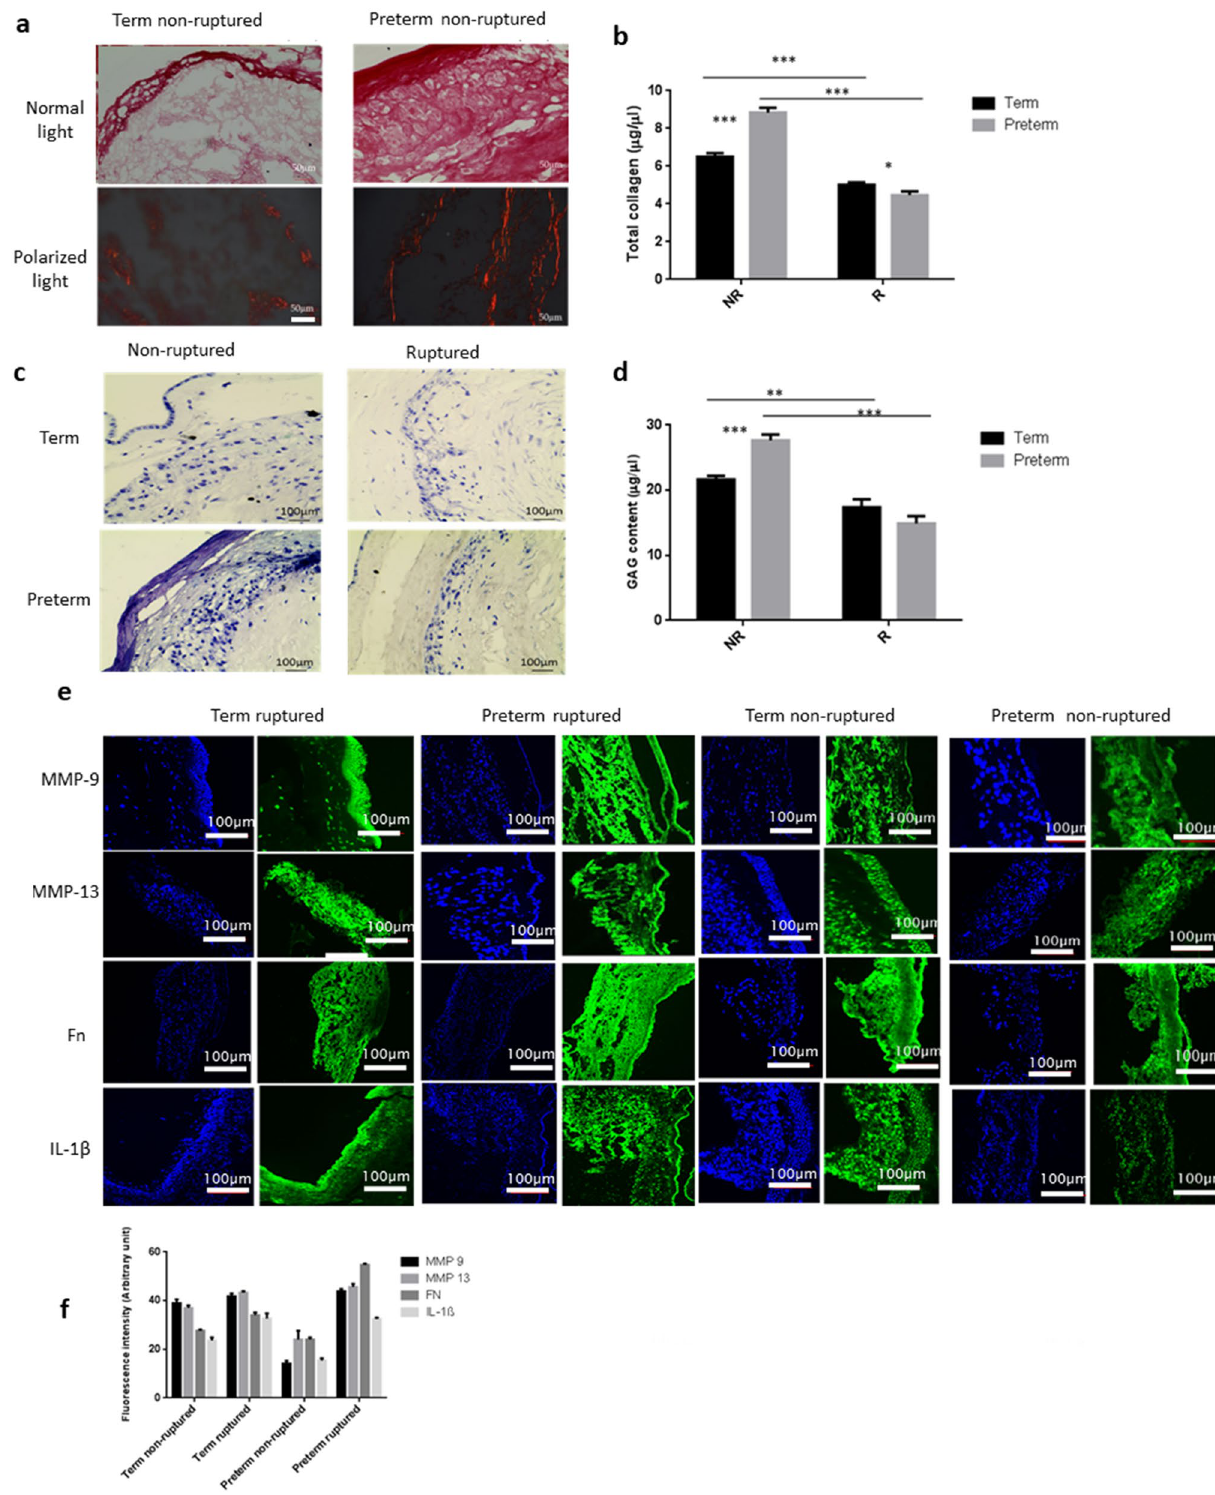
Figure 3. Histochemical and immunohistochemical analysis of key proteins and ECM molecules in the fetal membranes. ( a ) Pico Sirius Red staining of collagen fibres (n = 3). ( b ) Total collagen content (n = 3). NR, non-ruptured site. R, ruptured site. ( c ) Toluidine blue staining for sGAG (n = 3). ( d ) 1,9-dimethylmethylene blue (DMMB) assay for sGAG content. Data are presented as mean ± SD (n = 3). ** p < 0.01. *** p < 0.001. ( e ) Representative images showing biomarker expression (green) with counter staining by DAPI (blue). ( f ) Quantitative analyses of the immunostaining intensity. Fn fibronectin, IL interleukin, MMP metalloproteinase. Scale bar is 100